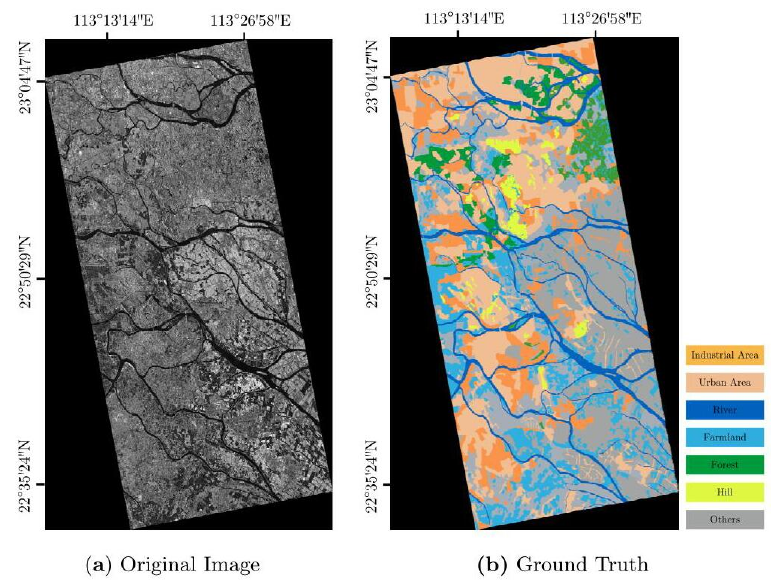
Figure 5. DataSet1 (7 categories): single-polarized (VV) data acquired by TerraSAR-X over Guangdong, China (intensity image).